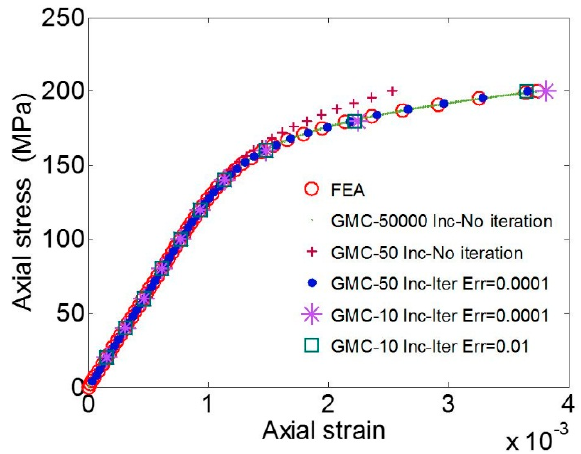
Figure 2. Average axial stress component ( σ zz ) vs . average axial strain ( ε zz ) determined by GMC